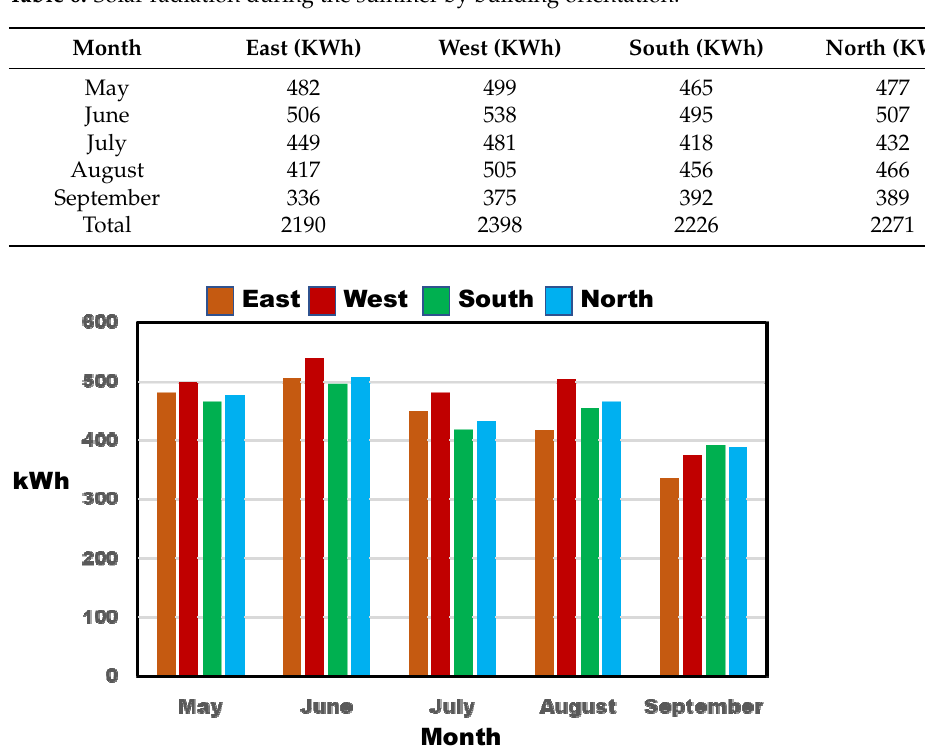
Figure 7. Solar radiation by building orientation during the